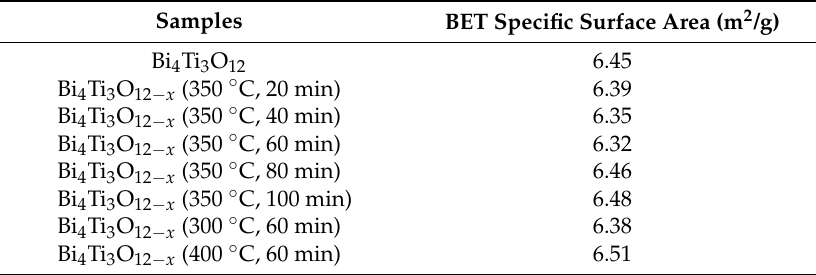
Bi 4 Ti 3 O 12 − x